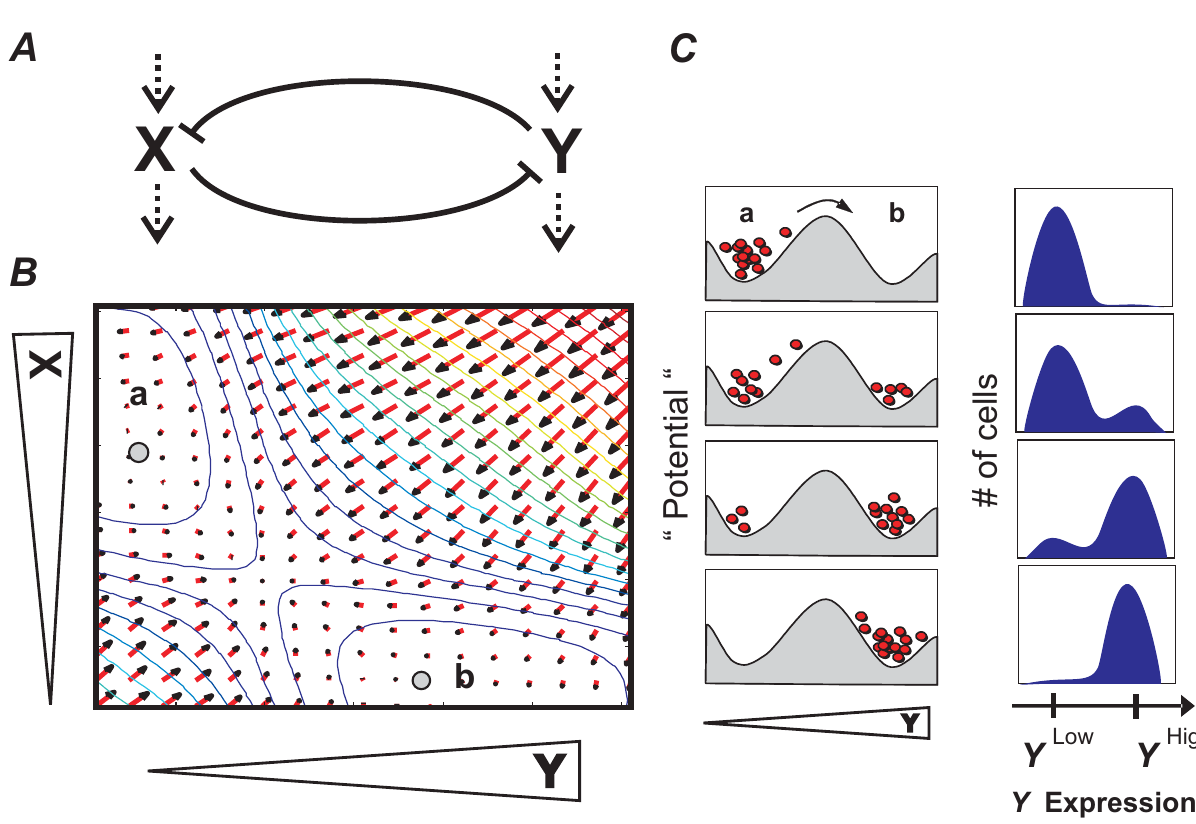
Figure 2 Bistable dynamics in a two-gene system with cross-regulation . A . Gene regulatory circuit diagram. Blunt arrows indi- cate mutual inhibition of genes X and Y . Dashed arrows indicate a basal synthesis (affected by the inhibition) and an independ- ent first-order degradation of the factors. B . Two-dimensional XY phase plane representing the typical dynamics of the circuit. Every point (X, Y) represents a momentary state defined by the values of the pair X, Y. Red arrows are gradient vectors indi- cating the direction and extent that the system will move to within a unit time at each of the (X, Y) positions. Collectively, the vector field gives rise to a "potential landscape", visualized by the colored contour lines (numerical approximation). In this "epi- genetic landscape", the stable states (attractors) are in the lowest points in the valleys: a (X>>Y) and b (Y>>X) (gray dots). C . Schematic representation of the epigenetic landscape as a section through a and b in which every red dot represents a cell. Experimentally, this bistability is manifested as a bimodal distribution in flow cytometry histograms in which the stable states a and b appear as peaks at the respective level of marker expression (e.g.,